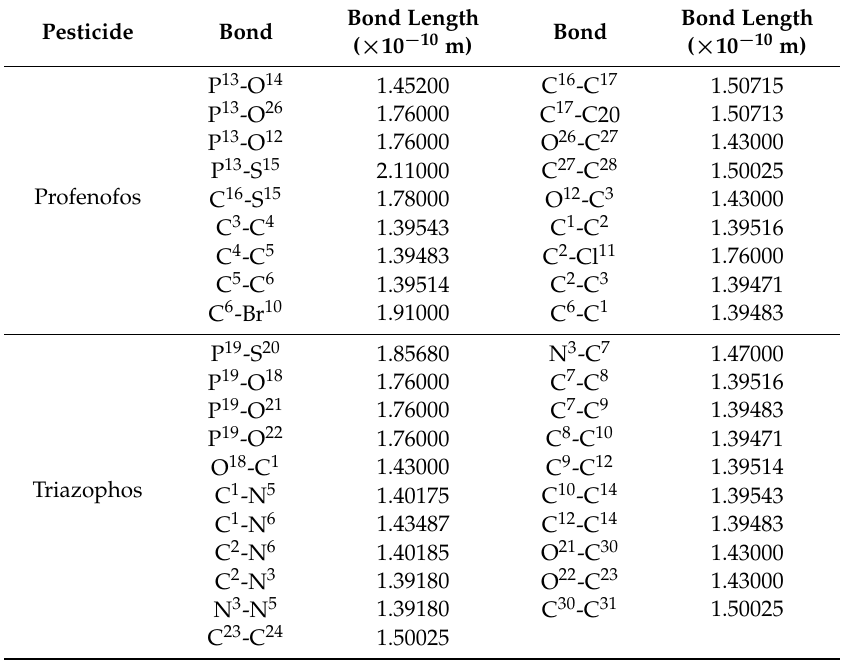
Figure 5. Spatial configuration of profenofos and triazophos molecule. ( A ) profenofos; ( B ) triazophos. Table 1. Bond length on main atoms in profenofos or triazophos molecules.